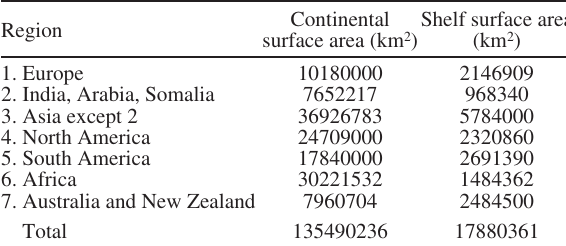
Table 1. – Surface of areas of continents and respective continental shelves with depths between 0 and 225 m.